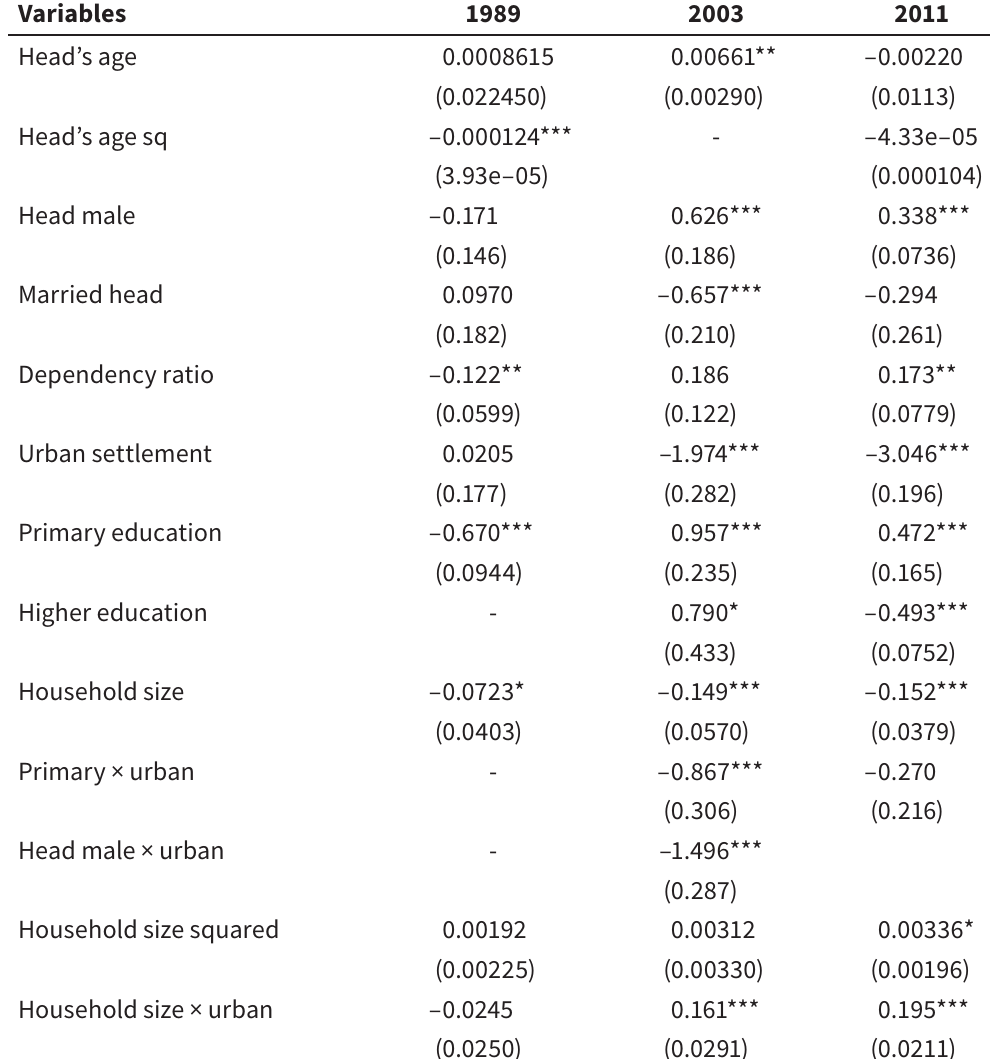
Semi-parametric Local Logistic Treatment Assignment Regression Model – Quantile Treatment Effect Estimation for Conflict